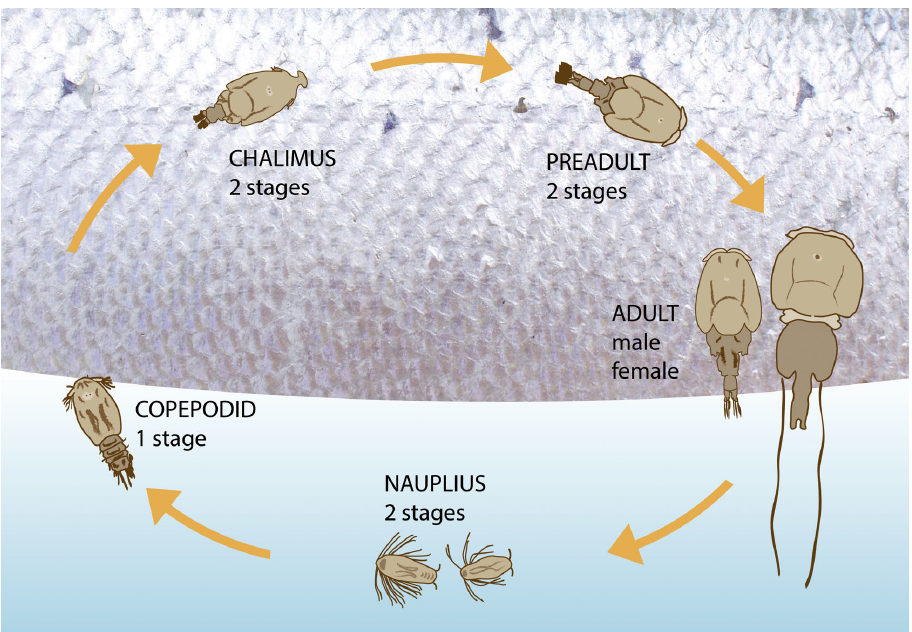
Fig. 1. The 5 phases of the salmon louse life cycle. Each phase comprises 1 or 2 life stages. The different phases are not shown scaled to size. Nauplius typically are of length ~0.5–0.6 mm, copepodids 0.7 mm, chalimi 1.1–2.3 mm, preadults 3.4–5.2 mm and adults 5–6 mm (males) and 8–12 mm (females). Graphic design: Kari Sivertsen,